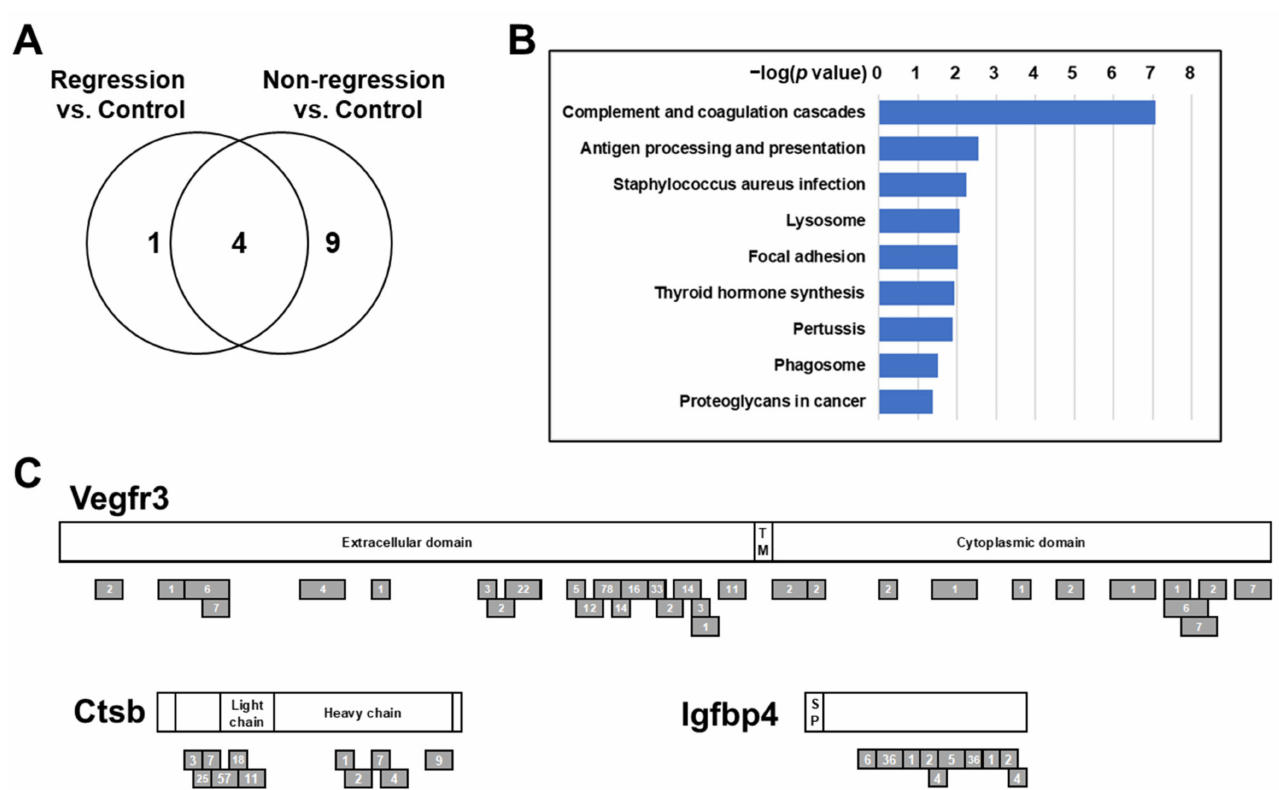
Figure 2. Proteomic analysis of pretreatment plasmas from iKAP mice with complete tumor regression and with residual tumors. ( A ). Venn diagrams of pathways are significantly associated with more than a two-fold increase of proteins in the plasma of Regression mice or Non-regression mice compared to control mice. ( B ). Pathways uniquely identified in the comparison of Non-regression vs. control. p values were calculated by hypergeometric test. ( C ). Schema of mouse Vegfr3, Ctsb, and Igfbp4. Gray bars indicate peptides identified in mouse plasma. Numbers indicate mass spectra counts for each peptide. The amino acid sequences are based on P35917-1 for Vegfr3, P10605-1 for Ctsb, and P47879-1 for